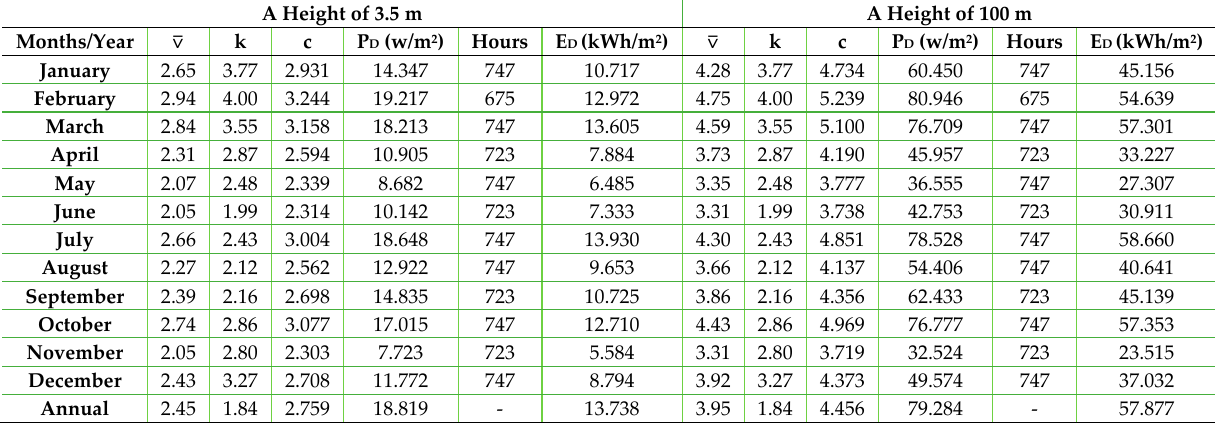
Table A2. Wind power and energy density characteristics at heights of 3.5 m and 100 m in Kudat.